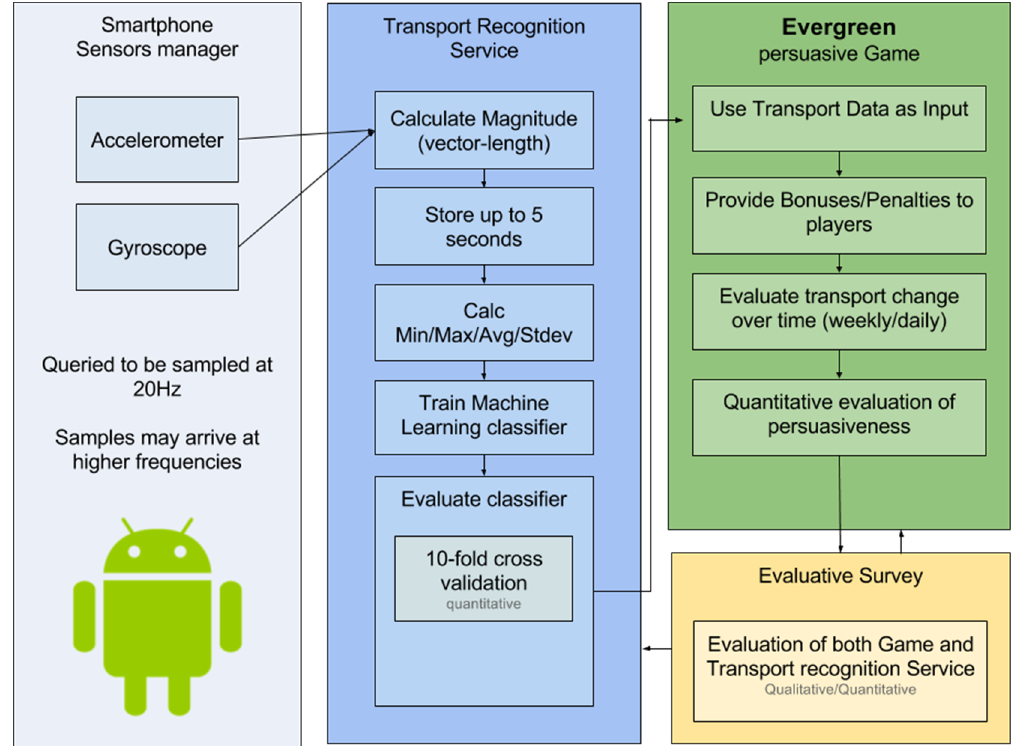
Figure 1. Overview of system architecture for Evergreen mobile application.